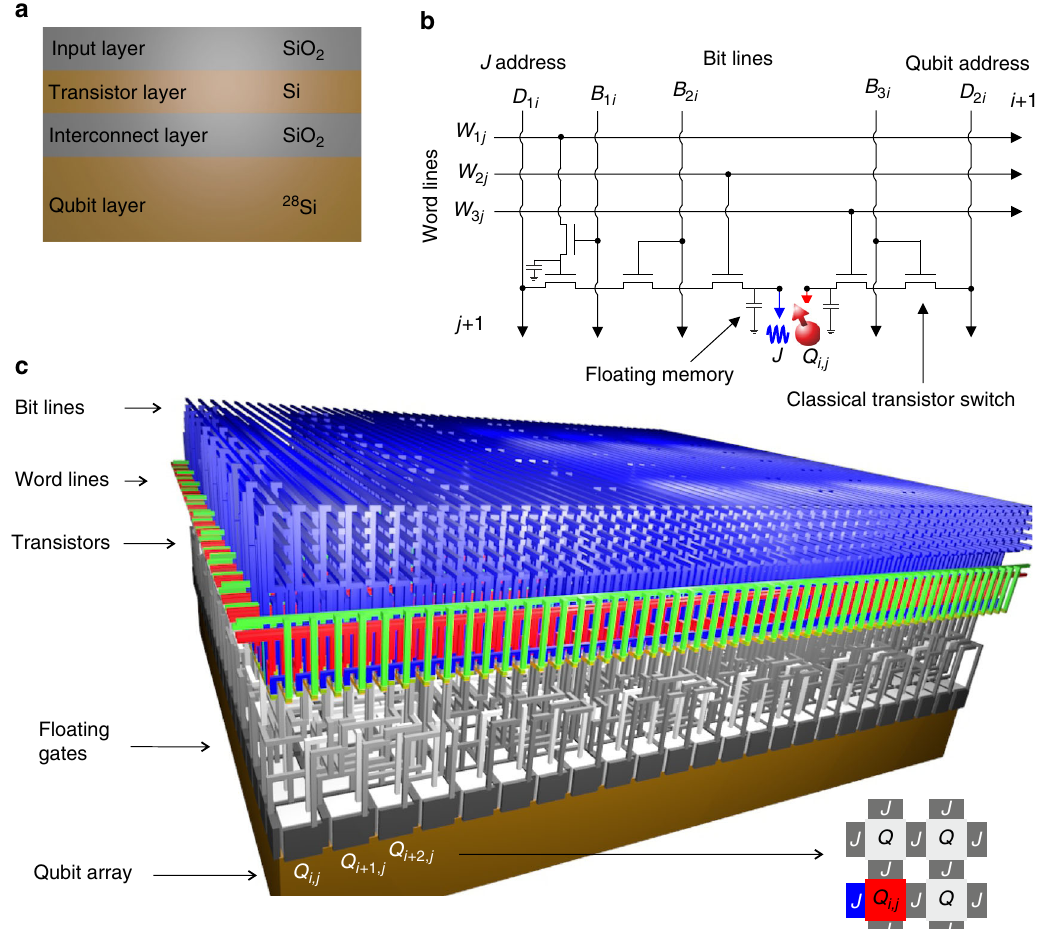
Fig. 1 Physical quantum processor. a A silicon-on-insulator (SOI) wafer is processed, such that the bottom layer of isotopically enriched silicon-28 contains the 2D qubit array and the top layer of silicon forms the transistors to operate the qubits. These are interconnected through the oxide regions using polysilicon (or other metal) vias. b Electrical circuit for the control of one Q -gate and one J -gate allowing the required individual, row-by-row, or global operations, as explained in the main text. c Physical architecture to operate one unit module containing 480 qubits. The inset on the bottom right shows a plan view cross-section through the qubit plane. Each J gate and qubit is connected via the circuit shown in